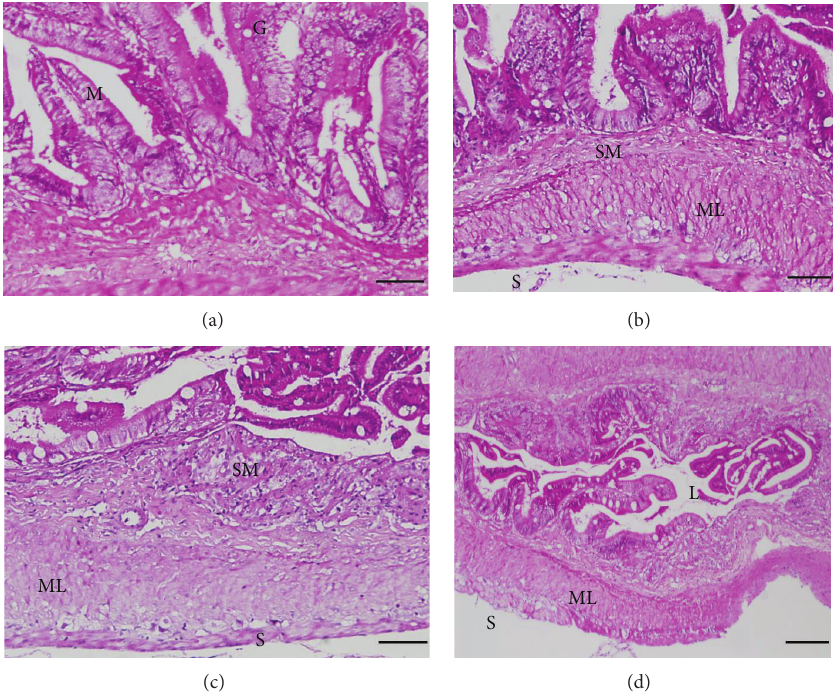
Figure 8: Histopathological observations in posterior part of cobia intestine injected with control PBS (i) and stimulation of cobia mixed with FKB, alum and 2137 (ii), 2395 (iii), and 1668 (iv) at 10 days after stimulation. Letters in the figure are denoted as M: mucosa epithelium, L: lumen, ML: muscular layer, SM: submucosa, LP: lamina propria, S: serosa, and G: goblet